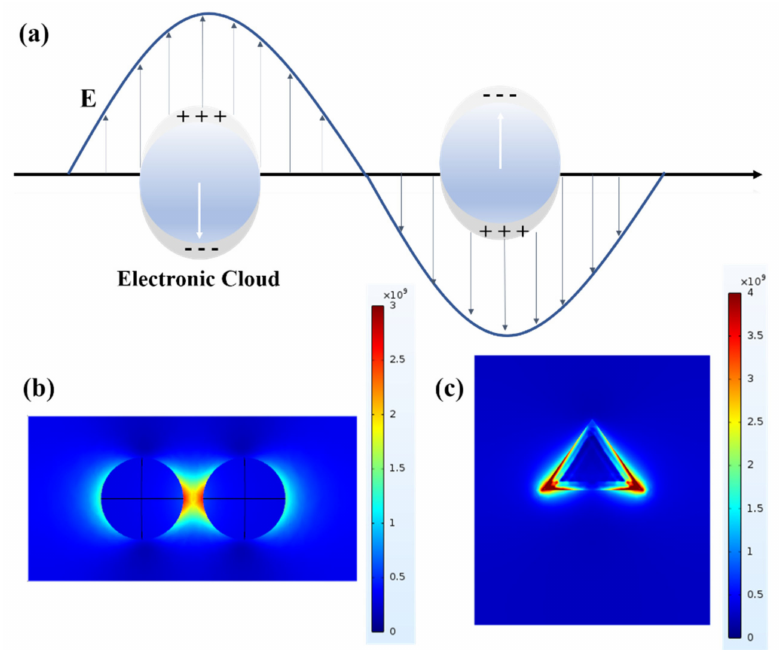
Figure 1. ( a ) Localized surface plasmon resonance on the surface of metal nanoparticles. ( b ) The hot spot with nanogap is when the two Au nanospheres with a diameter of 20 nm are separated by 3 nm. ( c ) The “tip-hot spot” effect at the tip of Au nanocones with regular tetrahedral structure. Unlike LSP, surface plasmon polaritons refer to the resonant coupling of free electrons and incident photons on the surface of metal substrates with periodic structures such as metal nanodiscs and gratings to form an electromagnetic mode. In this case, evanescent waves are generated at the dielectric interface and propagate parallel to the interface [29]. SPP refers to a new hybrid electromagnetic mode generated by the resonant coupling of in- cident photons of an external field and free electrons on the surface of metal nanosubstrates, which propagates horizontally along with the interface between the surface of the metal substrate and the mediu [30]. The electric field amplitude decays exponentially along the vertical direction of the interface. In general, the field attenuation of air or glass above the metal is 1/2 of the incident light wavelength, and the metal’s attenuation depends on the surface depth of the metal. The real ( K r ) and imaginary ( K i ) parts of the SPP wave